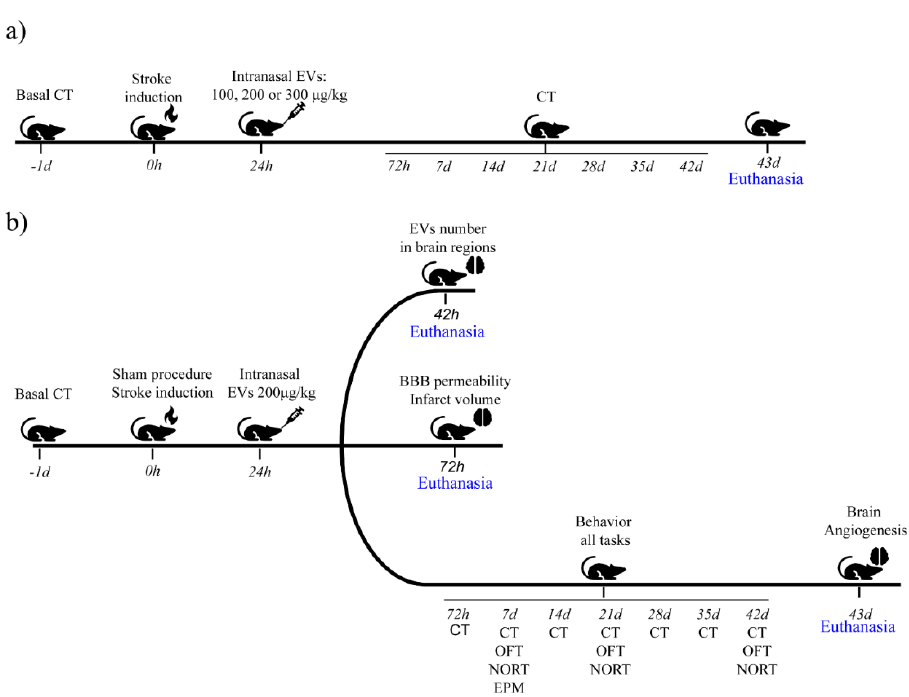
Figure 10. Experimental scheme. ( a ) Dose curve, animals received PBS or EVs (100, 200 or 300 µg/kg) intranasally 24 h after surgery. ( b ) Short- and long-term analyses: animals received PBS or EVs 200 µg/kg, intranasally 24 h after surgery. Short-term analyses: distribution of EVs in the brain, BBB permeability, and infarct volume; long-term analyses: CT: cylinder task; OFT: open field task; NORT: novel object recognition task; EPMT: elevated plus-maze task.